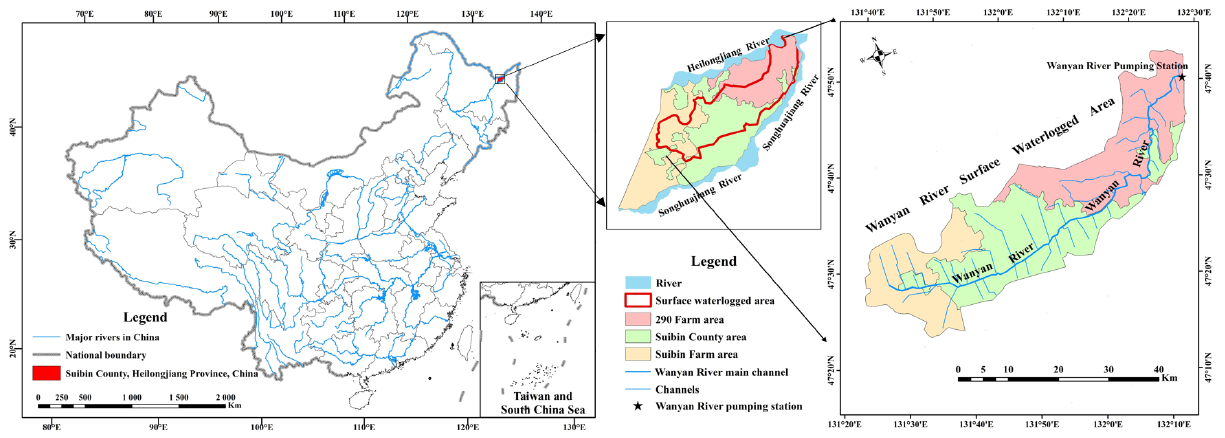
Figure 1. Location of the study